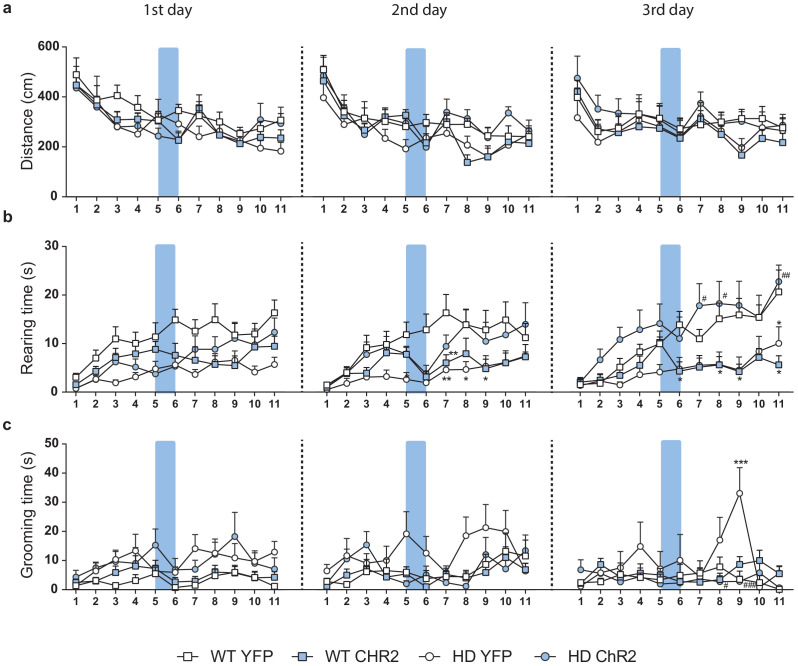
Representation of the changes in locomotion, exploration and stereotypies per minute during the whole 11 min OF sessions.(a) Distance traveled (cm), (b) rearing time (s), and (c) grooming time (s) per minute in 20-week-old WT-YFP, WT-ChR2, HD-YFP, and HD-ChR2 mice during the 1st (left), 2nd (middle), and 3rd (right) open field sessions. The blue box represents the duration of blue light stimulation (1 min). Repeated measures ANOVA with group and time as factors followed by Bonferroni’s post hoc comparisons test was performed. Bonferroni post hoc comparisons are shown when the interaction effect was found. Values are expressed as mean ± SEM (WT-YFP n = 10, WT-ChR2 n = 11, HD-YFP n = 13, and HD-ChR2 n = 11).